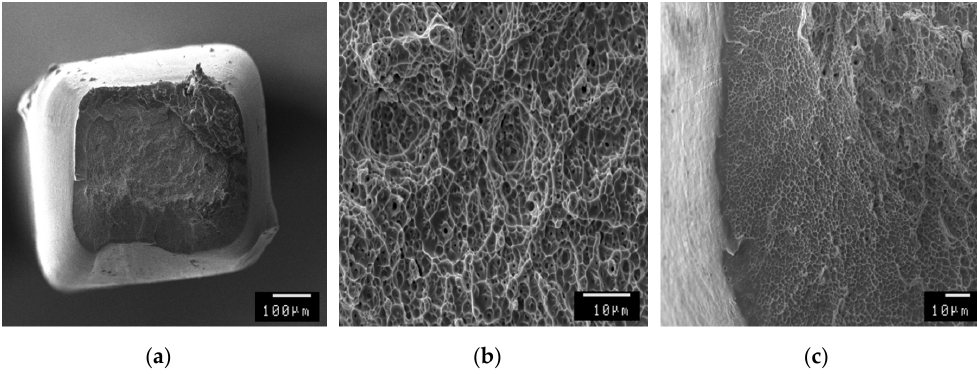
Figure 11. Scanning Electron Microscope images of typical fracture surfaces of annealed specimen: ( a ) general view; magnified views of ( b ) center parts and ( c ) outer part of specimen.